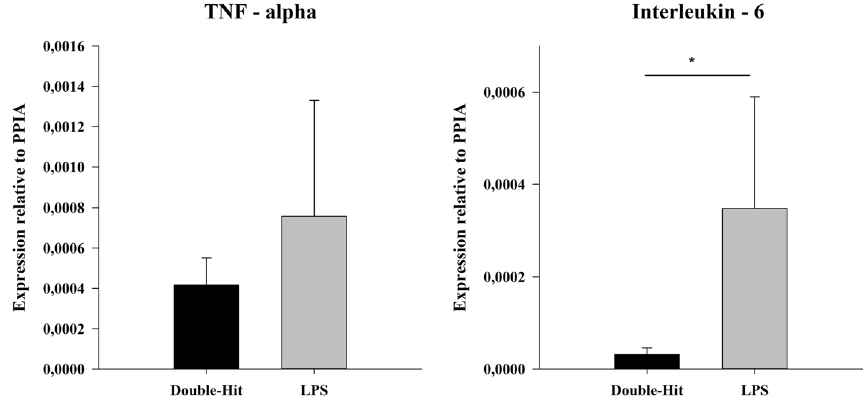
Fig. 2 Pulmonary expressions of inflammatory